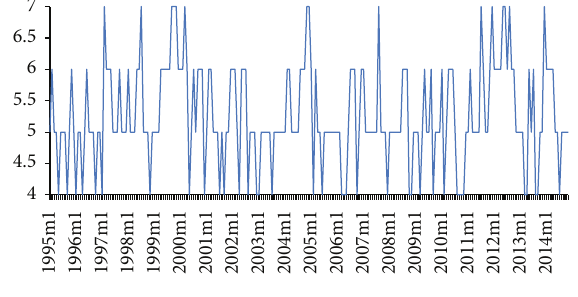
Figure 4: Maximum number of links as a function of 𝑇 . We used time windows of 𝑇 = 12 months and window step length parameter Δ𝑇 = 1